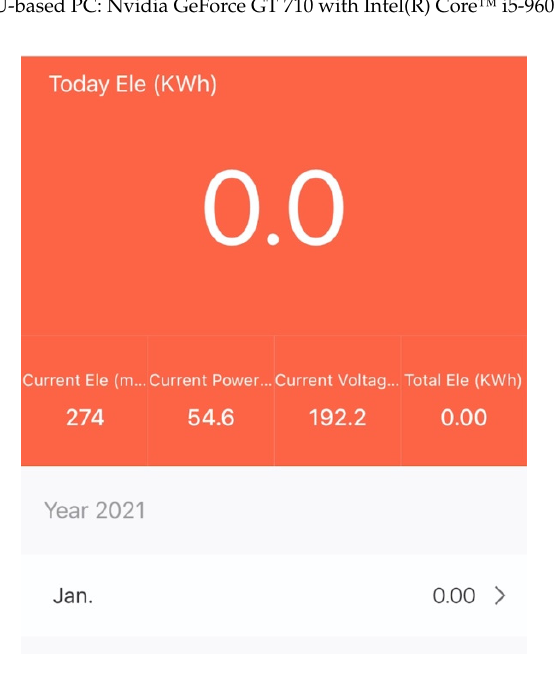
Figure 16. The method of average power consumption using a PC.